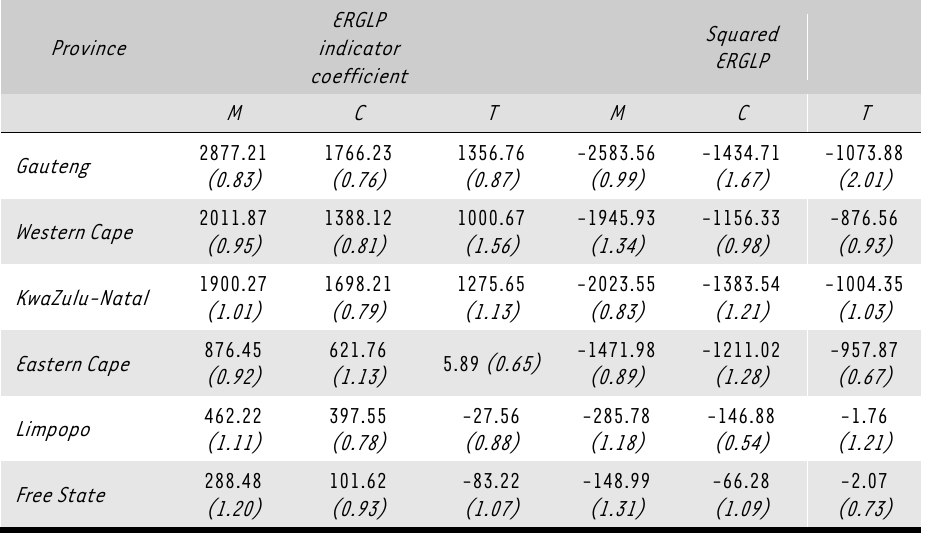
TABLE 1: ERGLP indicator coefficients for the different industries in the different geographical areas ERGLP Province